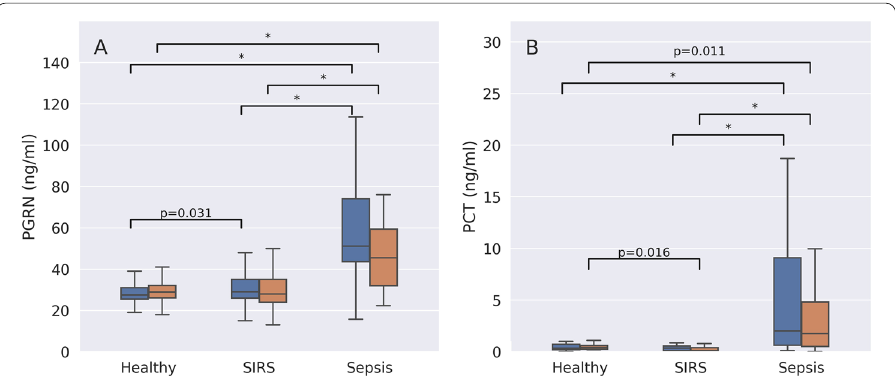
Fig. 5 Comparison of progranulin (PGRN, A ) and procalcitonin (PCT, B ) plasma concentrations in healthy volunteers, patients with SIRS and patients with either sepsis or septic shock ("Sepsis") at study inclusion. Data are presented separately for the exploratory (blue boxplots) and the confirmatory study (orange boxplots). *Indicates a p < 0.001, significant p values 0.001 are given as numbers ≥